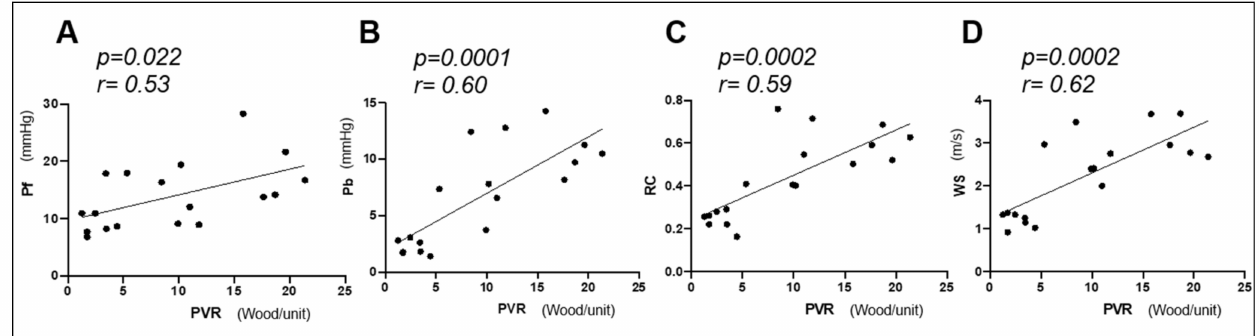
Figure 5. Correlation between pulmonary vascular resistance (PVR) and pulmonary artery wave reflection (PAWR) variables (Pf ( A ), forward-traveling pressure; Pb ( B ), backward-traveling pressure; RC ( C ), reflection coefficient; WS ( D ), wave speed). r, the correlation coefficient. There was a significant positive correlation between PVR and PAWR parameters ( p <